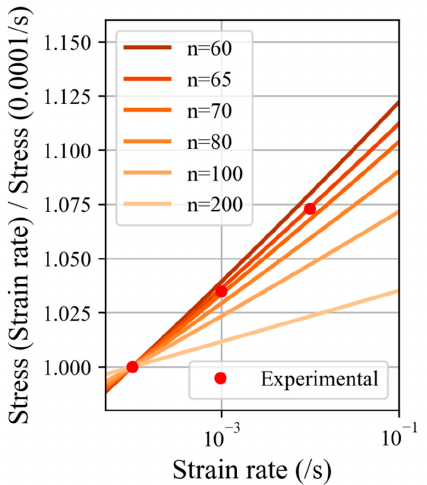
Figure 15. Strain rate dependence of stress for different values of the strain rate sensitivity exponent. The squares represent the strain rate dependence of the material extracted from the three tensile curves at different strain rates in Figure 9, assuming that 𝜀 (cid:2868) (cid:4662) = 0.0001/s . Although both DAMASK and VPSC can be successfully used for the fitting of the hardening parameters, the method that uses the VPSC model has the advantage of requiring much less